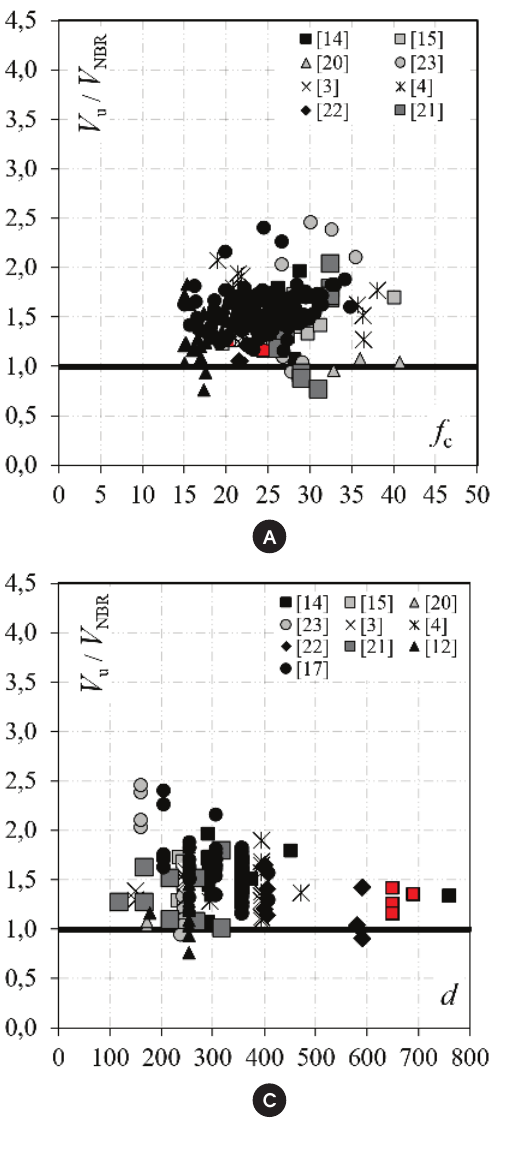
Comparison between experimental results and recommendations of NBR 6118 [6]